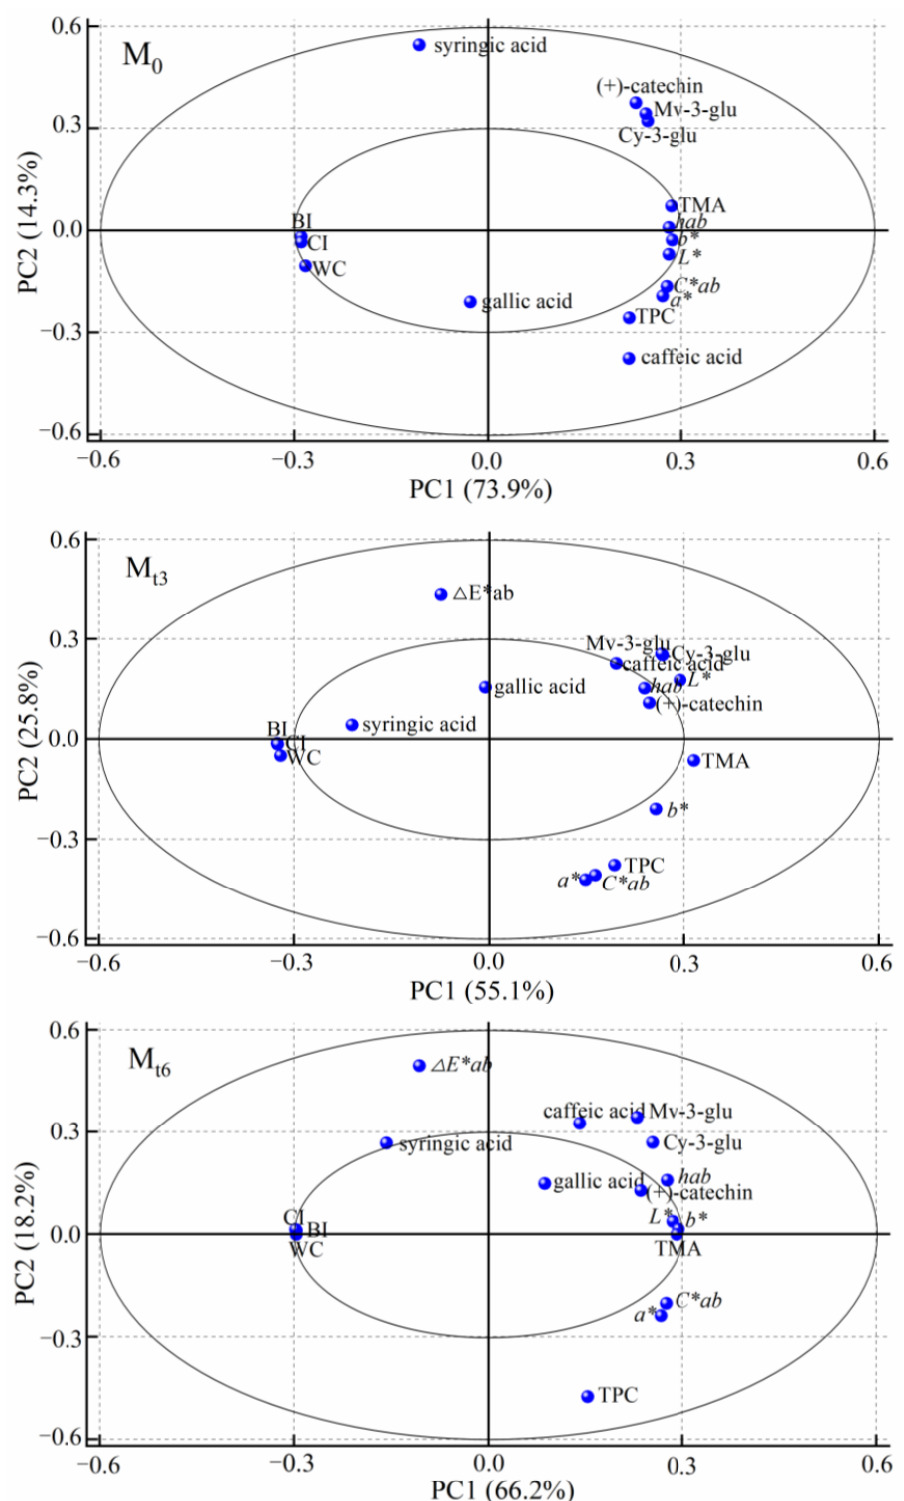
Figure 5. Scatter plot of PCA loading for M 0 , M t3 , and M t6 during storage.